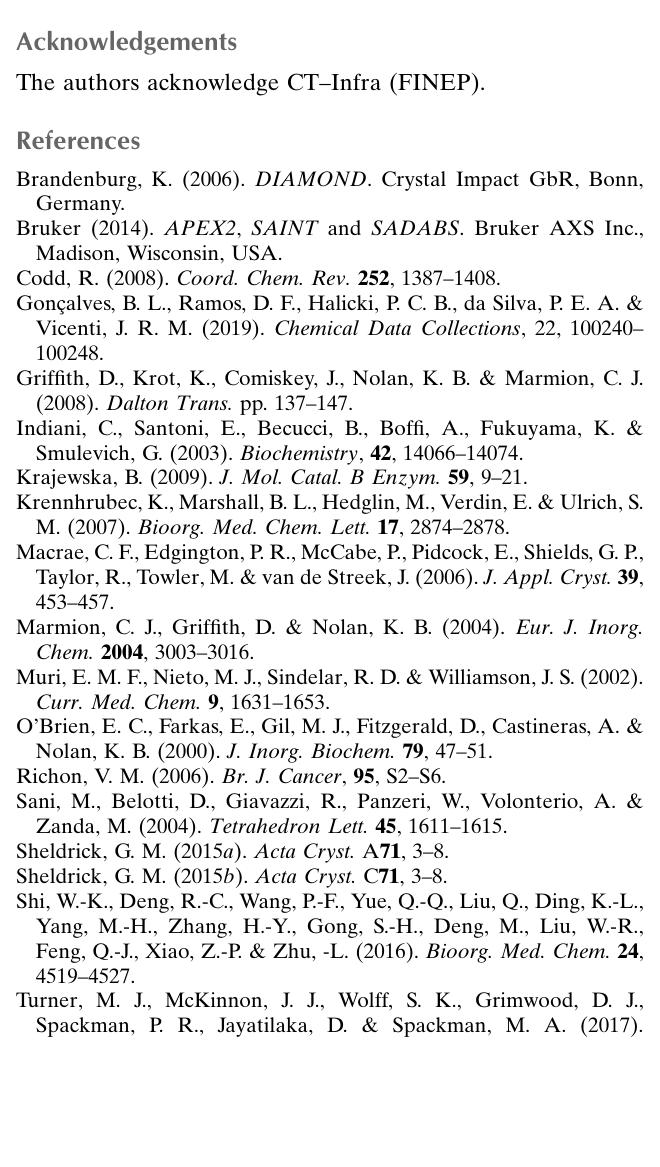
Crystal data Chemical